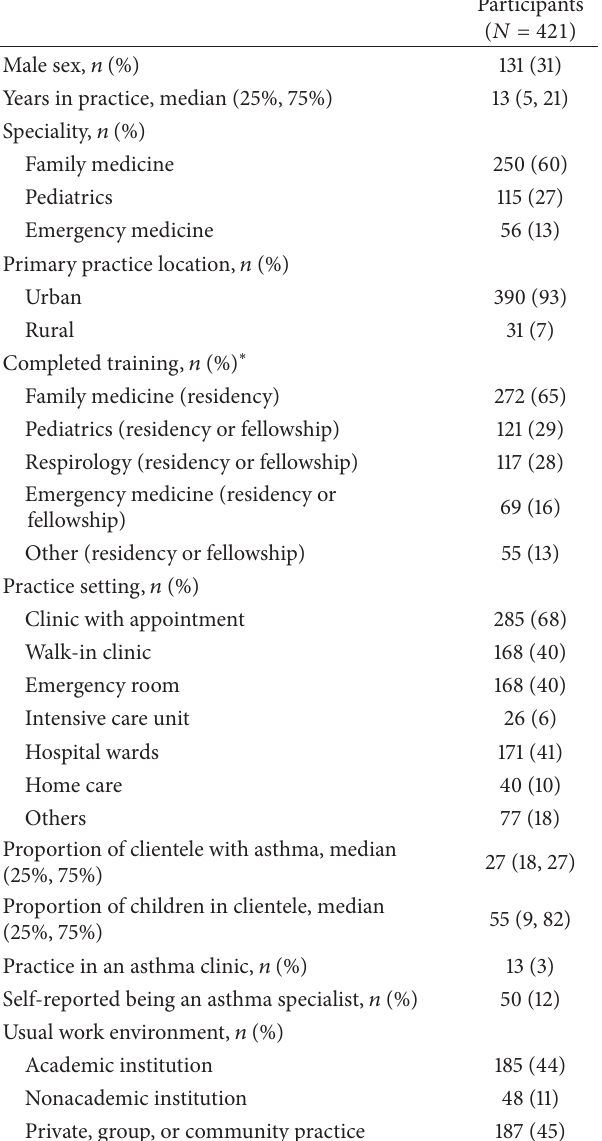
Table 1: Characteristics of